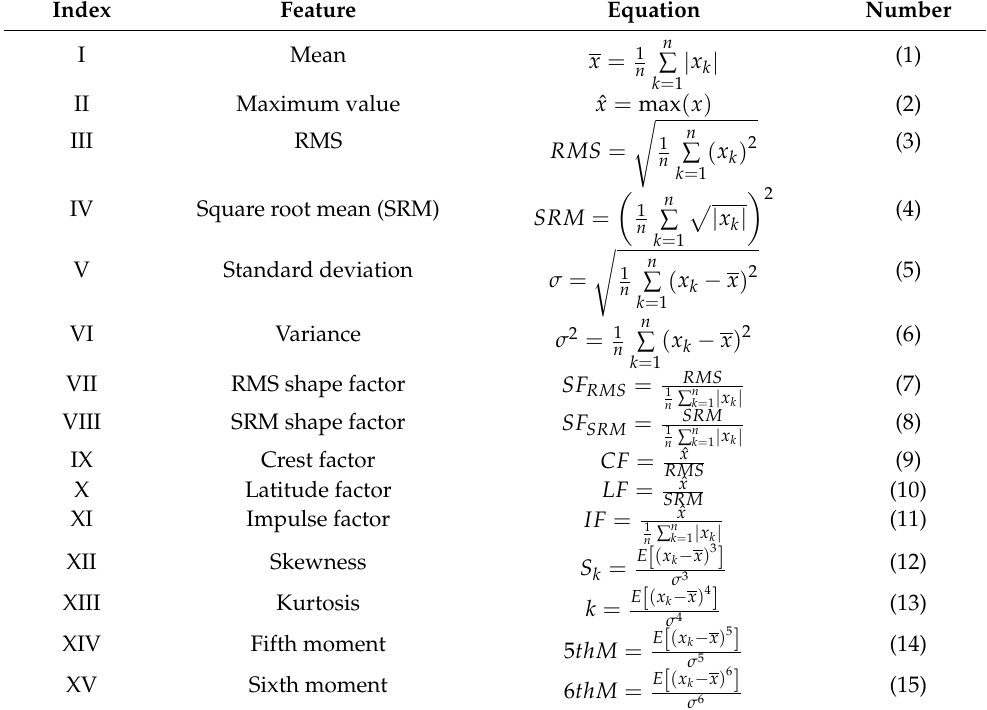
Table 1. Time domain statistical